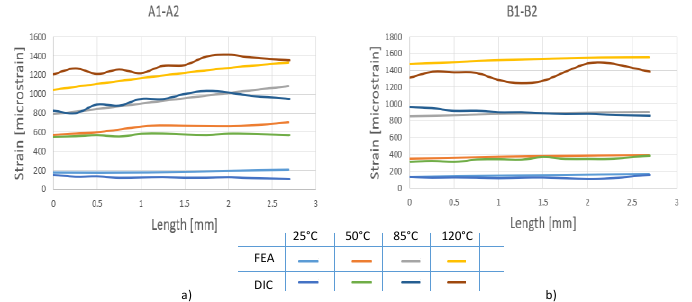
Figure 14. DIC vs. FEA — Comparison of principal strain: ( a ) A1 – A2 path; ( b ) B1 – B2 path.